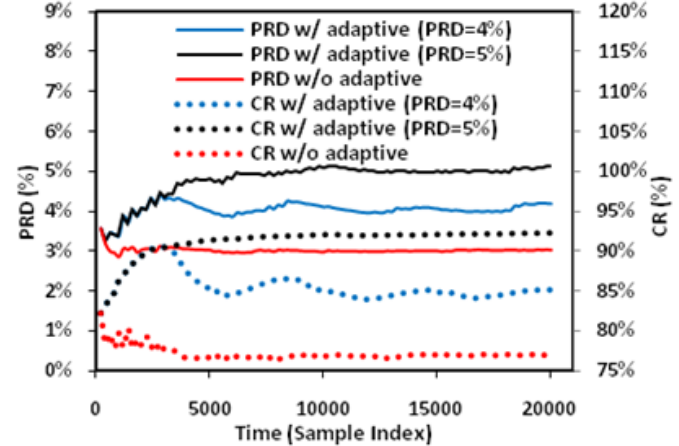
Figure 10. Effect of adaptive angle threshold tuning.